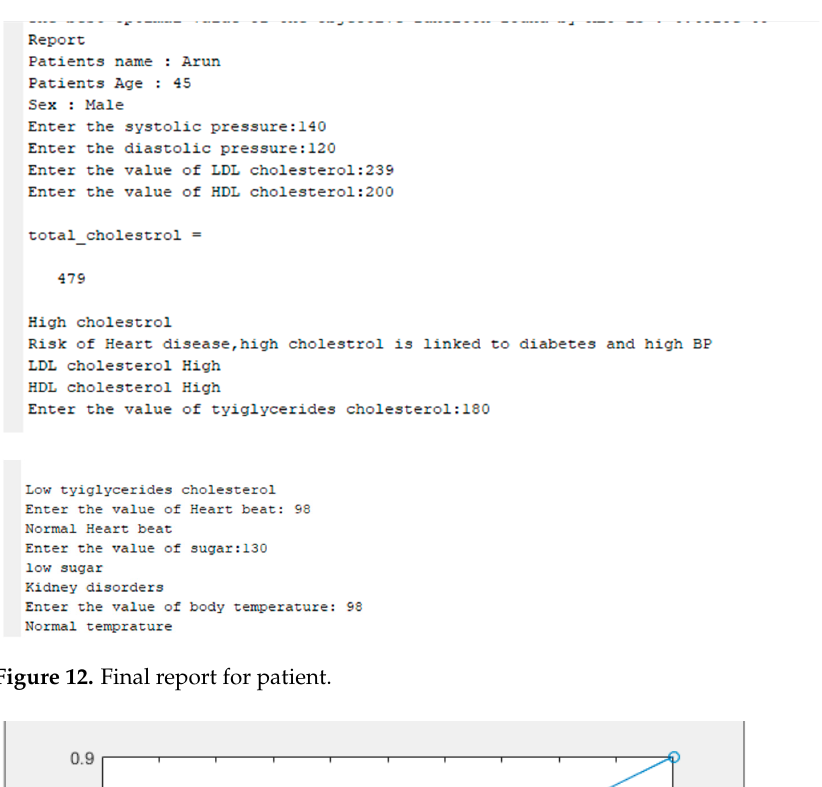
Figure 11. Result: ( a ) Menu Button ( b ) Sugar Check Up.